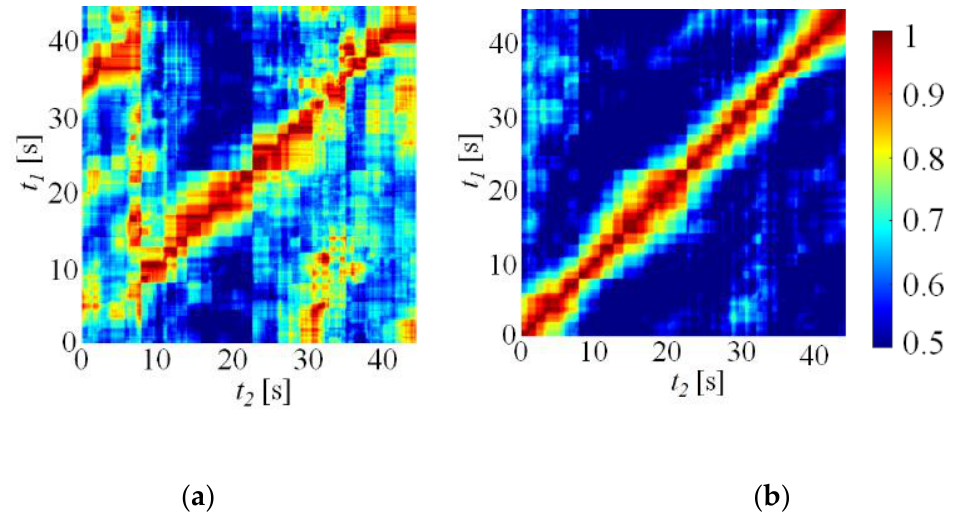
Figure 9. Cross-correlations of heat fluxes at two positions of Ch1 at Q ele = 3.5 W, ( a ) 1a and 1d, ( b ) 1c and 1d.